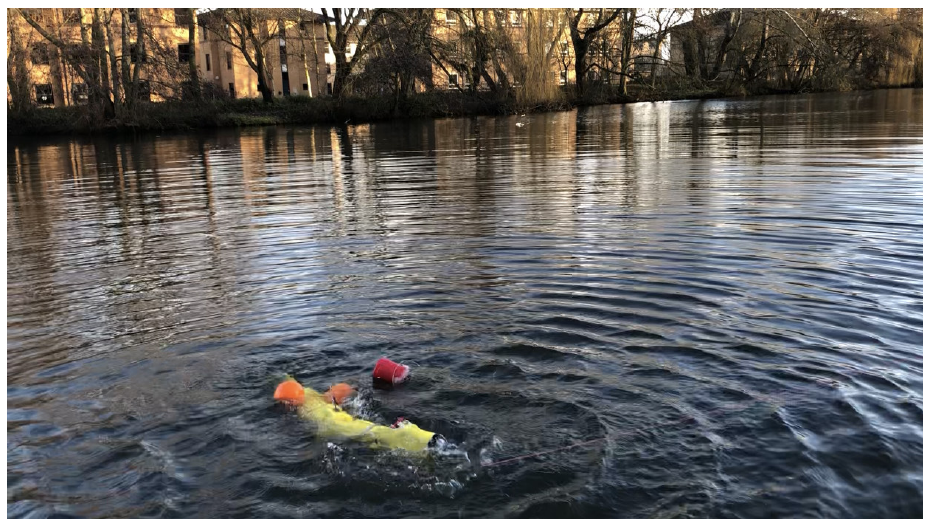
Figure 17. RoboFish prototype swimming on the surface of a lake: two side plastic buoys were included to maintain positive buoyancy; a rope was attached to it to drag it to the home point in the case of failure or battery